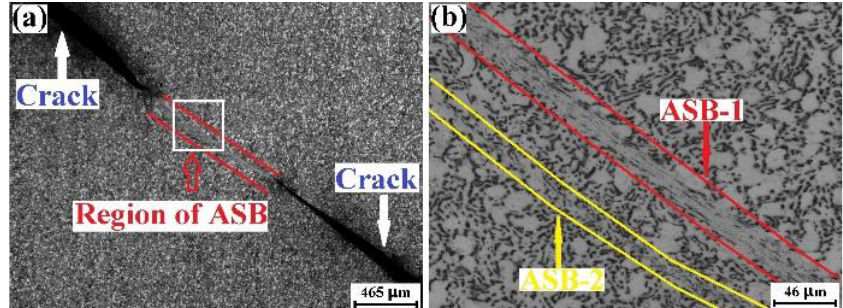
Figure 9. Optical micrographs regarding the adiabatic shearing behavior of mill-annealed Ti-6Al-4V alloy plate compressed in the TD. The loading direction is vertical. ( a ) Optical micrograph for the ASB and the crack induced by the ASB, ( b ) high-magnification optical micrograph for the rectangle region of Figure 9a.